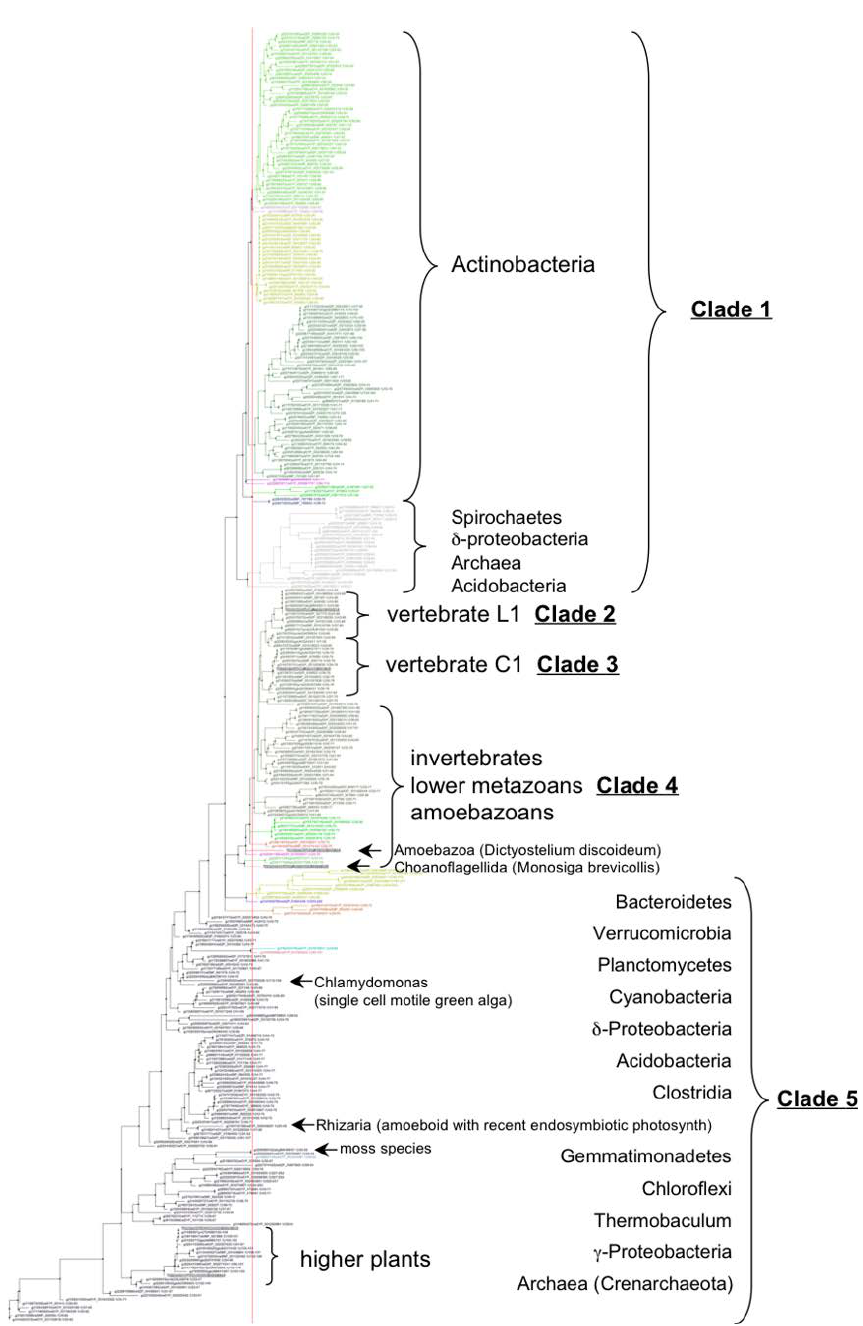
Figure 3. Cladogram (unrooted tree) of VKORloop sequences identifying groupings into highest common Linnaean taxonomic ranks. (See online supplemental data for a complete listing of protein identifiers in the FASTA-formatted MSA file; also, Figure S7 of the online Supplementary Materials and Research Data shows the full-length aligned sequences, including non-VKOR domains, corresponding to the cladogram in this figure).